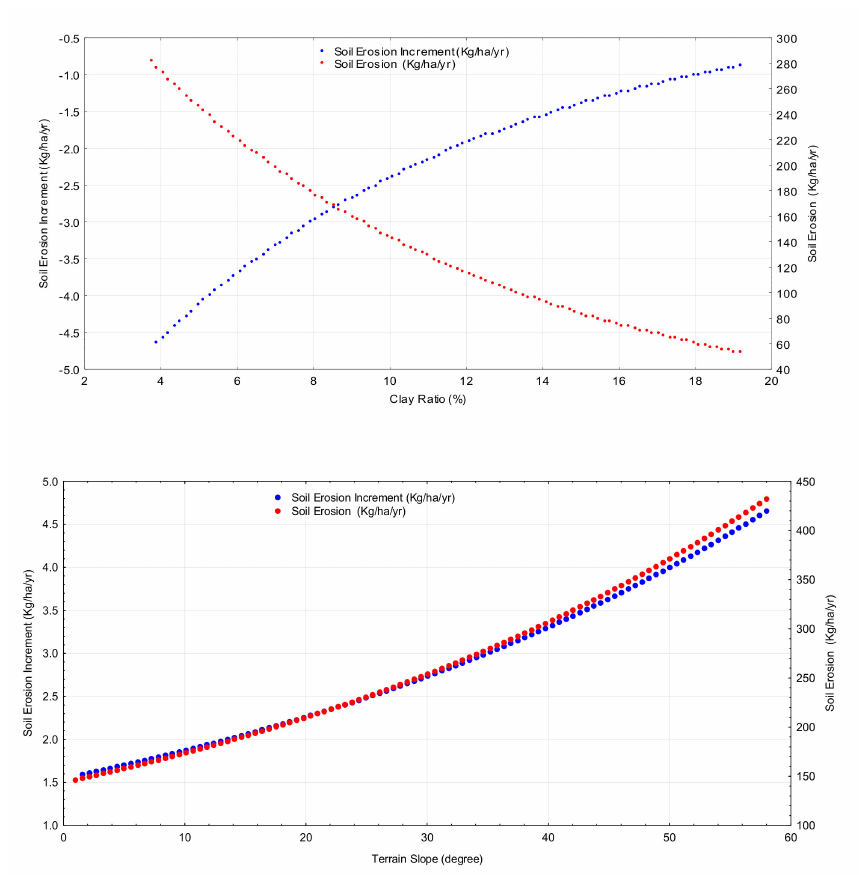
Figure 3. Incremental effect analysis of the soil-erosion model to independent